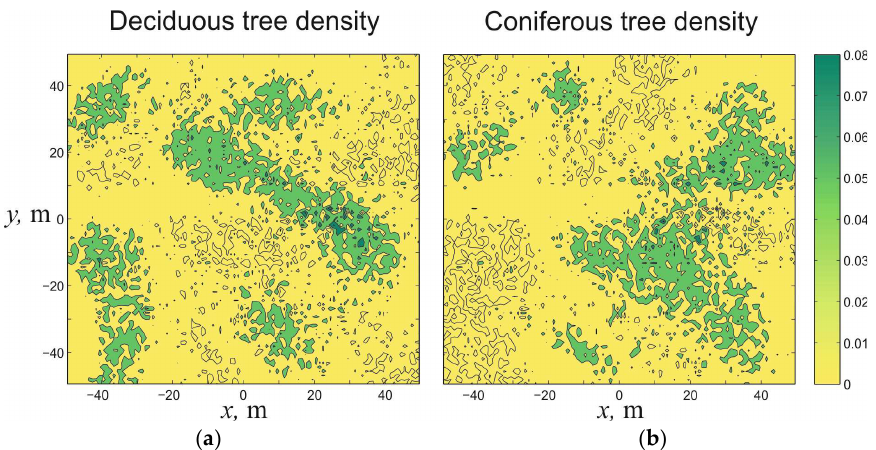
Figure 9. The result of the functions ρ 1 ( x , y ) ( a ) and ρ 2 ( x , y ) ( b ) retrieving on the N x × N y ≡ 100 × 80 grids for a set of measurements of N p = 10 points with simulated errors δ = 5%, h = 6%.